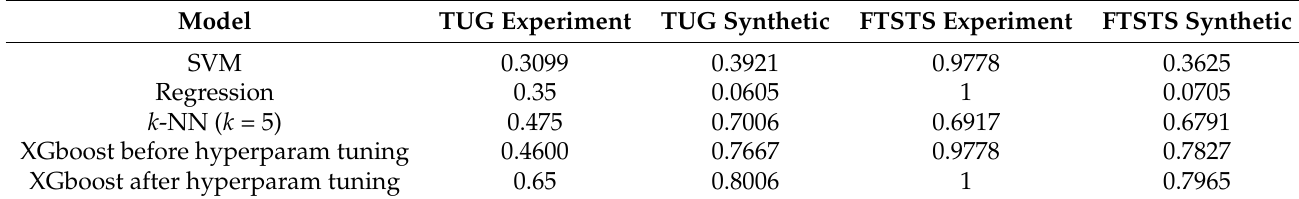
Table 1. Fivefold cross-validation accuracy results of ML models. Accuracy is calculated as the fraction of correct predictions using sklearn.metrics.accuracy_score .